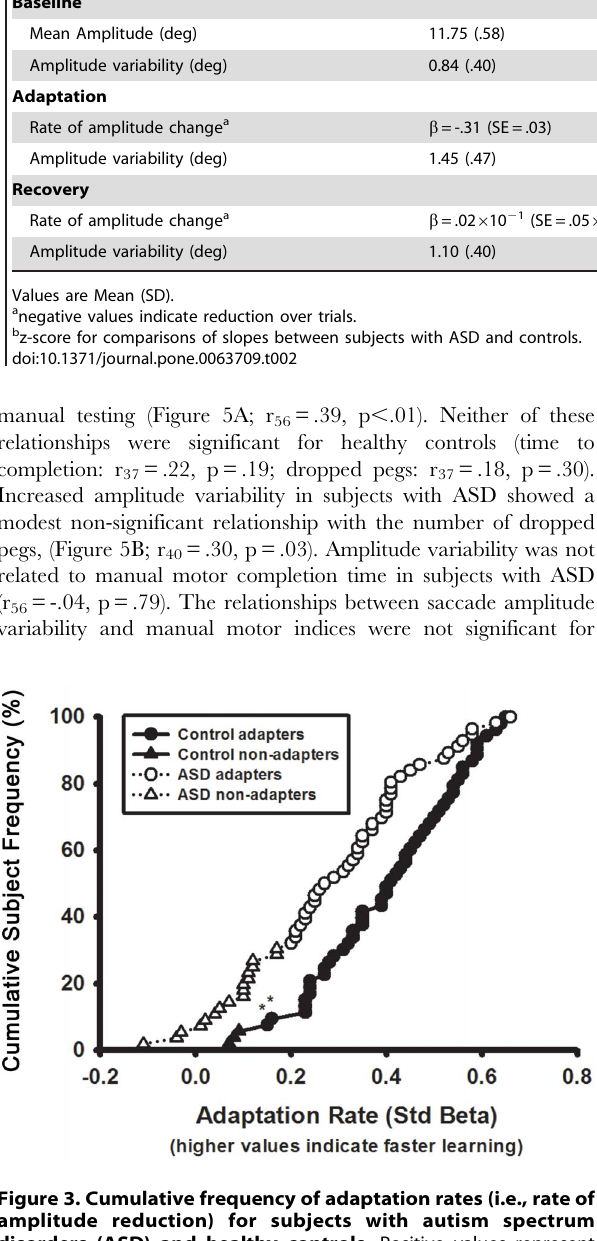
Figure 3. Cumulative frequency of adaptation rates (i.e., rate of amplitude reduction) for subjects with autism spectrum disorders (ASD) and healthy controls. Positive values represent faster learning rates. Triangles are used to represent non-adapters for both diagnostic groups. Asterisks (*) are used to identify two control subjects whose rates of adaptation were statistically significant (p , .05) but also less than those of two non-adapting subjects with ASD. These two controls made more saccades that could be scored during adaptation (151 and 170 out of 180 respectively) than the two non- adapting subjects with ASD whose learning rate was faster but non- significant (133 and 135 out of 180 respectively). If these two subjects with ASD are re-classified as adapters, there is still a higher proportion of non-adapting ASD subjects compared to healthy controls (ASD: 27% (15/56); controls: 6% (3/53); X 2 1 =8.81, p ,